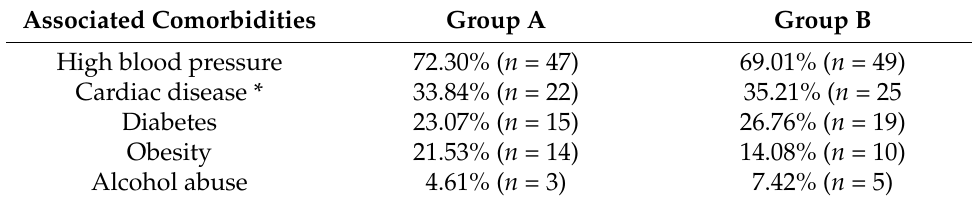
Table 1. Comorbidities in Group A (surgical) and B (medical).